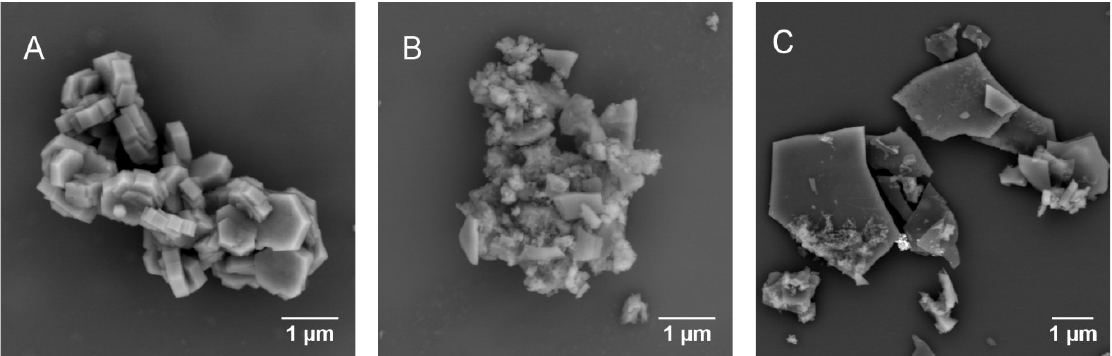
Figure 5. SEM images of ICR-9Cryst (A), ICR-9A (B), and ICR-9B (C)